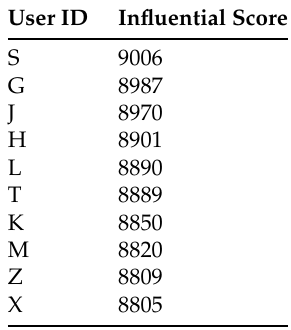
Table 11. Top- K query